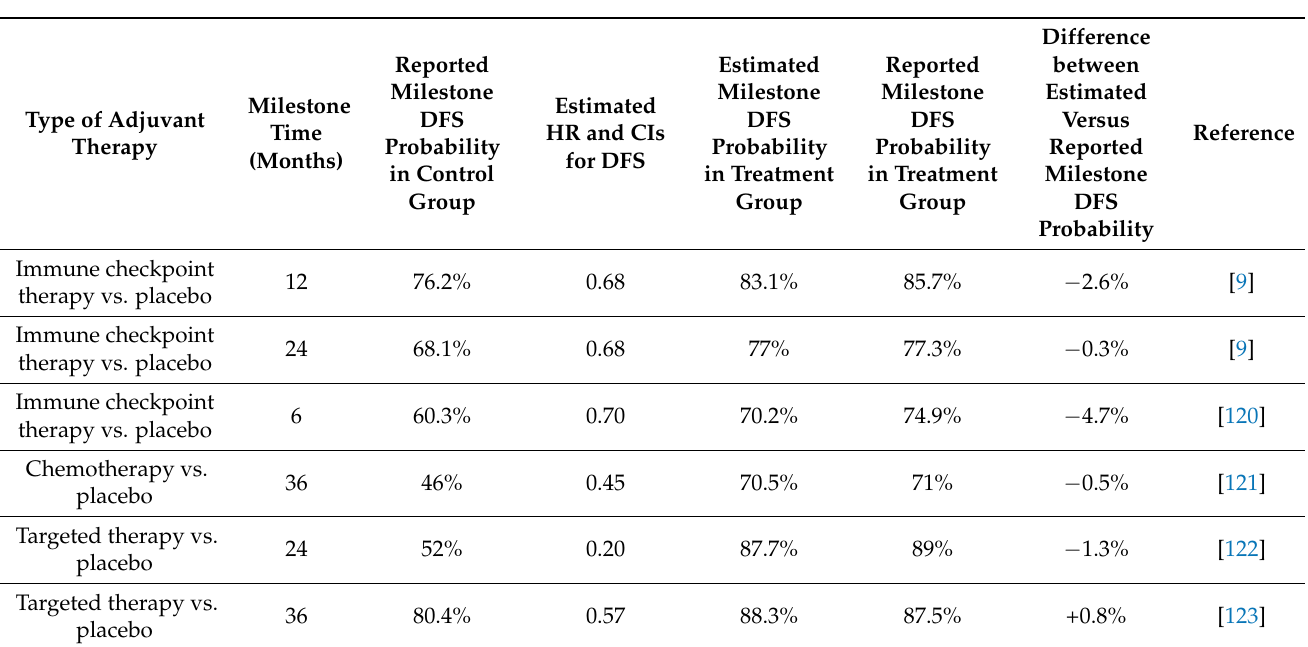
Table 3. Estimated and reported milestone survival probabilities using the treatment effect calculator (Supplementary File S1) assuming an exponential survival distribution in adjuvant therapy trials. DFS = disease-free survival, HR = hazard